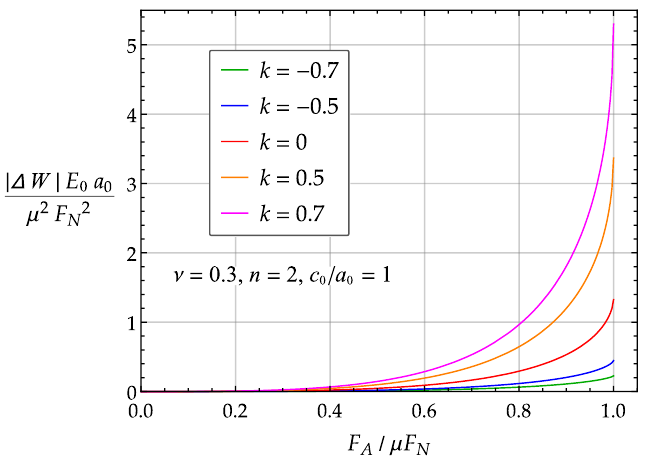
Figure 12. Dissipated energy during one cycle of tangential fretting for a parabolic initial gap function and various exponents of elastic inhomogeneity 𝑘 ; the red curve indicates the classical solution of Mindlin et al. (1952) for elastically homogeneous material.